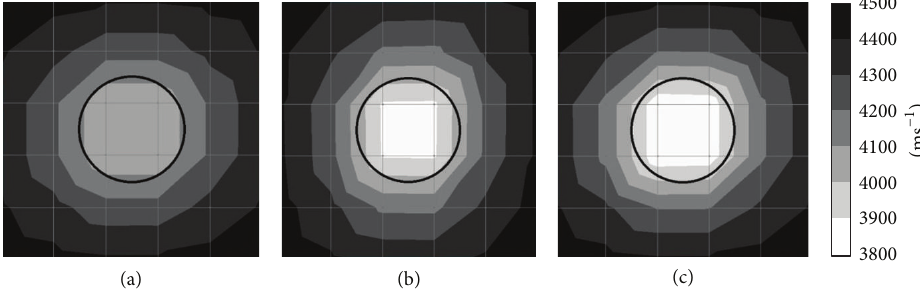
Figure 10: Tomograms simulated by 25 elements: (a) 0% void; (b) 50% void; and (c) 100% void.